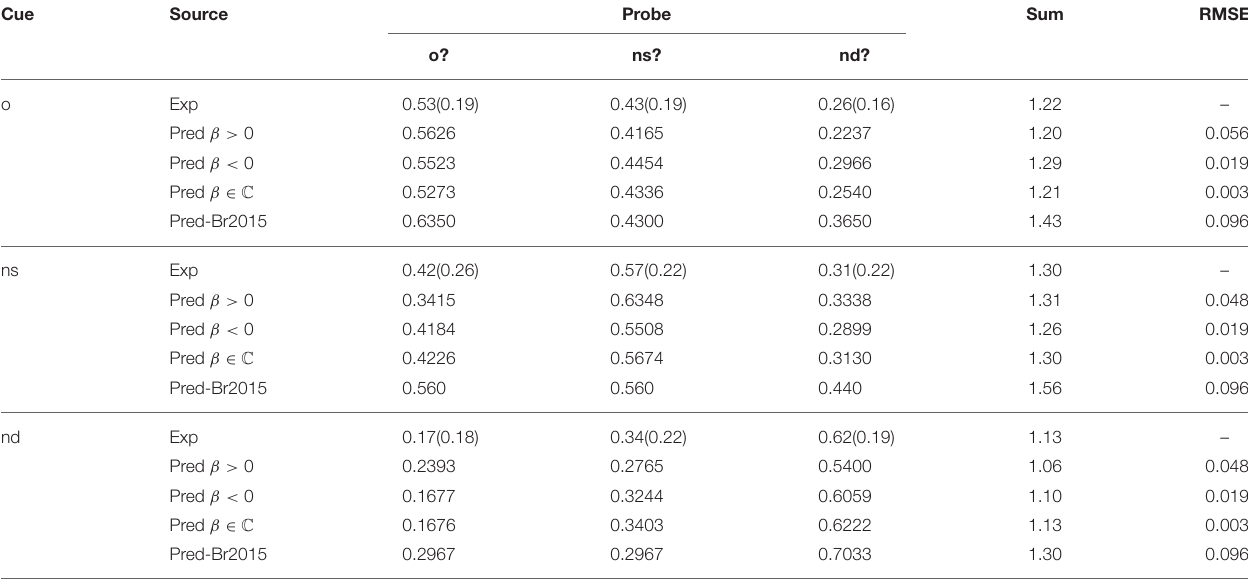
TABLE 2 | EOD-subadditivity: Experimental and predicted acceptance probabilities by probe and cue in item false memory paradigm—immediate test [1]. Cue Source Probe